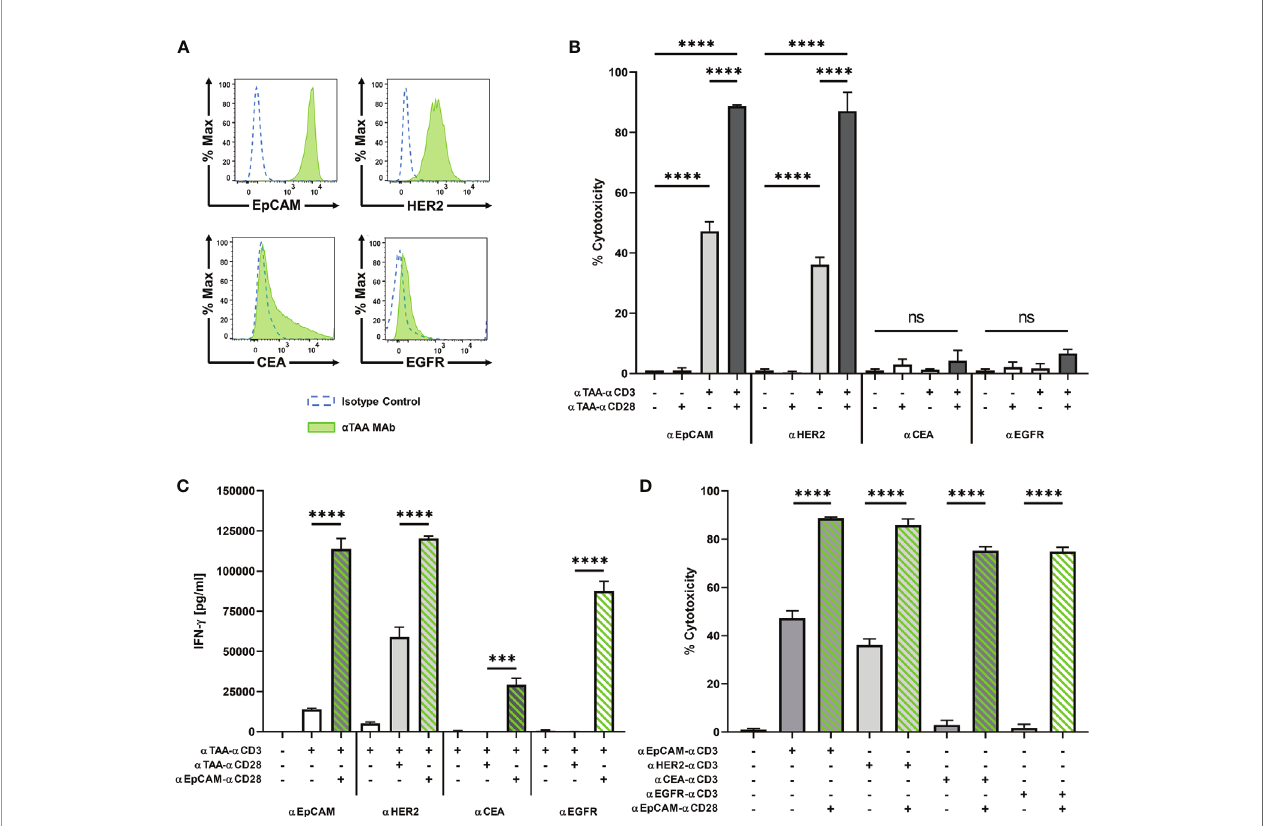
FIGURE 3 | BiMAb induce T cell activation in a target antigen-dependent manner. MCF-7 cells were co-cultured with puri fi ed unstimulated T cells in the presence or absence of 1 nM a CD3 +/- a CD28 BiMAb targeting the tumor-associated antigens (TAA), EpCAM, HER2, CEA, or EGFR as indicated. (A) TAA cell surface expression on MCF-7 cells was analyzed by fl ow cytometry using a TAA monoclonal antibodies (green fi lled lines) and isotype control antibodies (dotted blue lines). Mean fl uorescence intensities for EpCAM, HER2, CEA and EGFR were 8523, 828, 733 and 71, respectively. (B) Tumor cell lysis based on LDH release was measured in supernatants collected after 48h of co-culture of T cells in the presence of the indicated stimulatory and co-stimulatory BiMAb. Co-stimulatory a EpCAM – a CD28 BiMAb rescue T cell activation. (C) IFN- g secretion (in pg/ml) in T cell co-cultures with MCF-7 cells and the indicated a TAA – a CD3 ± a TAA – a CD28 BiMAb was measured after 48 h by ELISA. (D) 2D co-culture assays were performed using combinations of a TAA – a CD3 with a EpCAM – a CD28 BiMAb to validate a split co-stimulation approach. Cytotoxicity measurements were based on LDH released by lysed tumor cells after 48 h. Data represent mean values ± SEM from 3 independent experiments in triplicates with statistical analysis by one-way ANOVA test followed by Tukey ’ s multiple comparison test (B – D) , ns, not signi fi cant; *** p < 0.001; **** p <